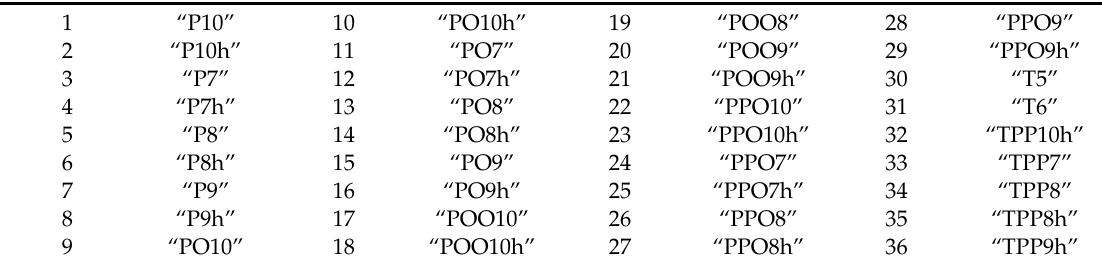
Figure A3. L1 norm of the columns of the Ex transfer matrix without the non-cerebellar brain (i.e. row 35). The rectangle shows the electrode locations with the high L1 norm (electrodes relevant for cerebellar stimulation in Ex). Table A3. List of electrode locations relevant for cerebellar stimulation in Ex (L1 norm > 1.3).